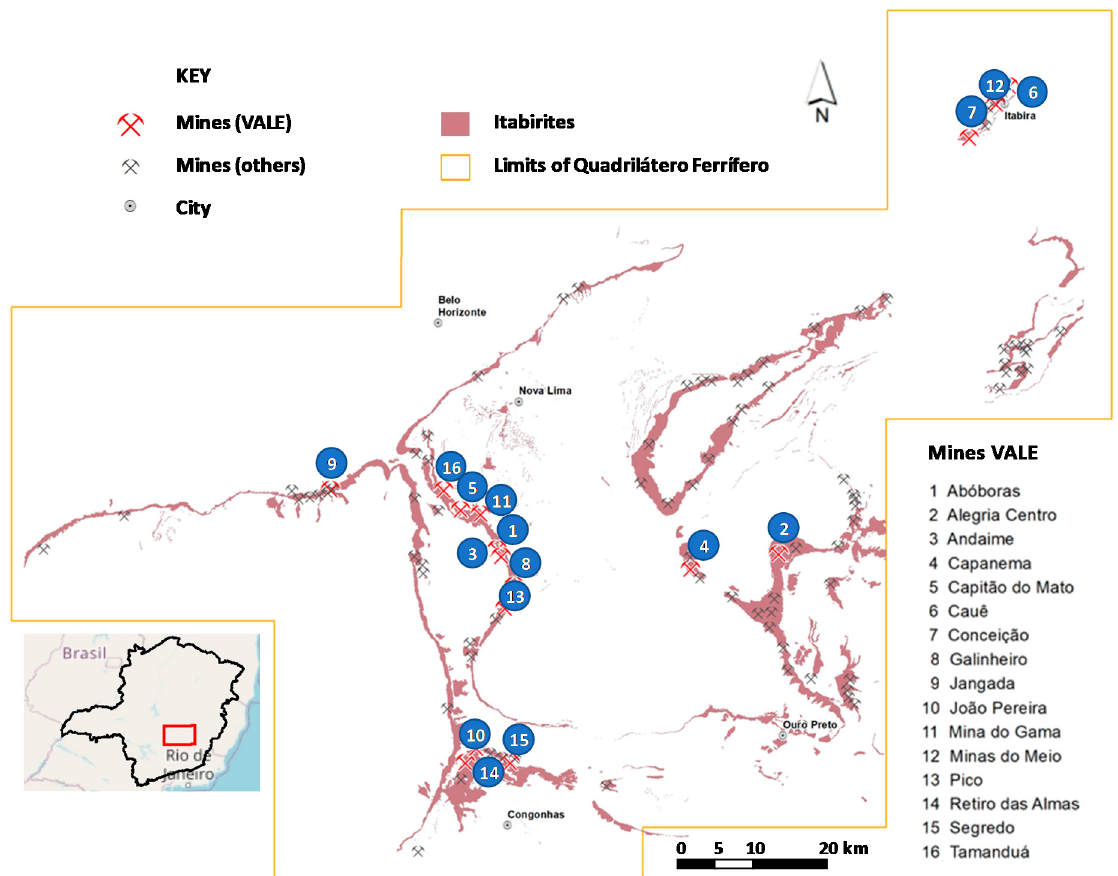
Figure 1. Location of the Vale’s iron ore mines in Quadrilátero Ferrífero.